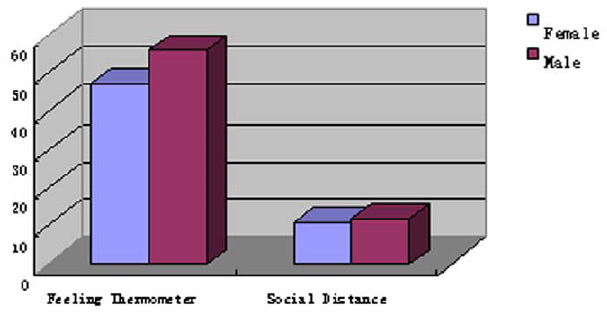
Figure 2. Gender differences in explicit stigma toward mental disorder.